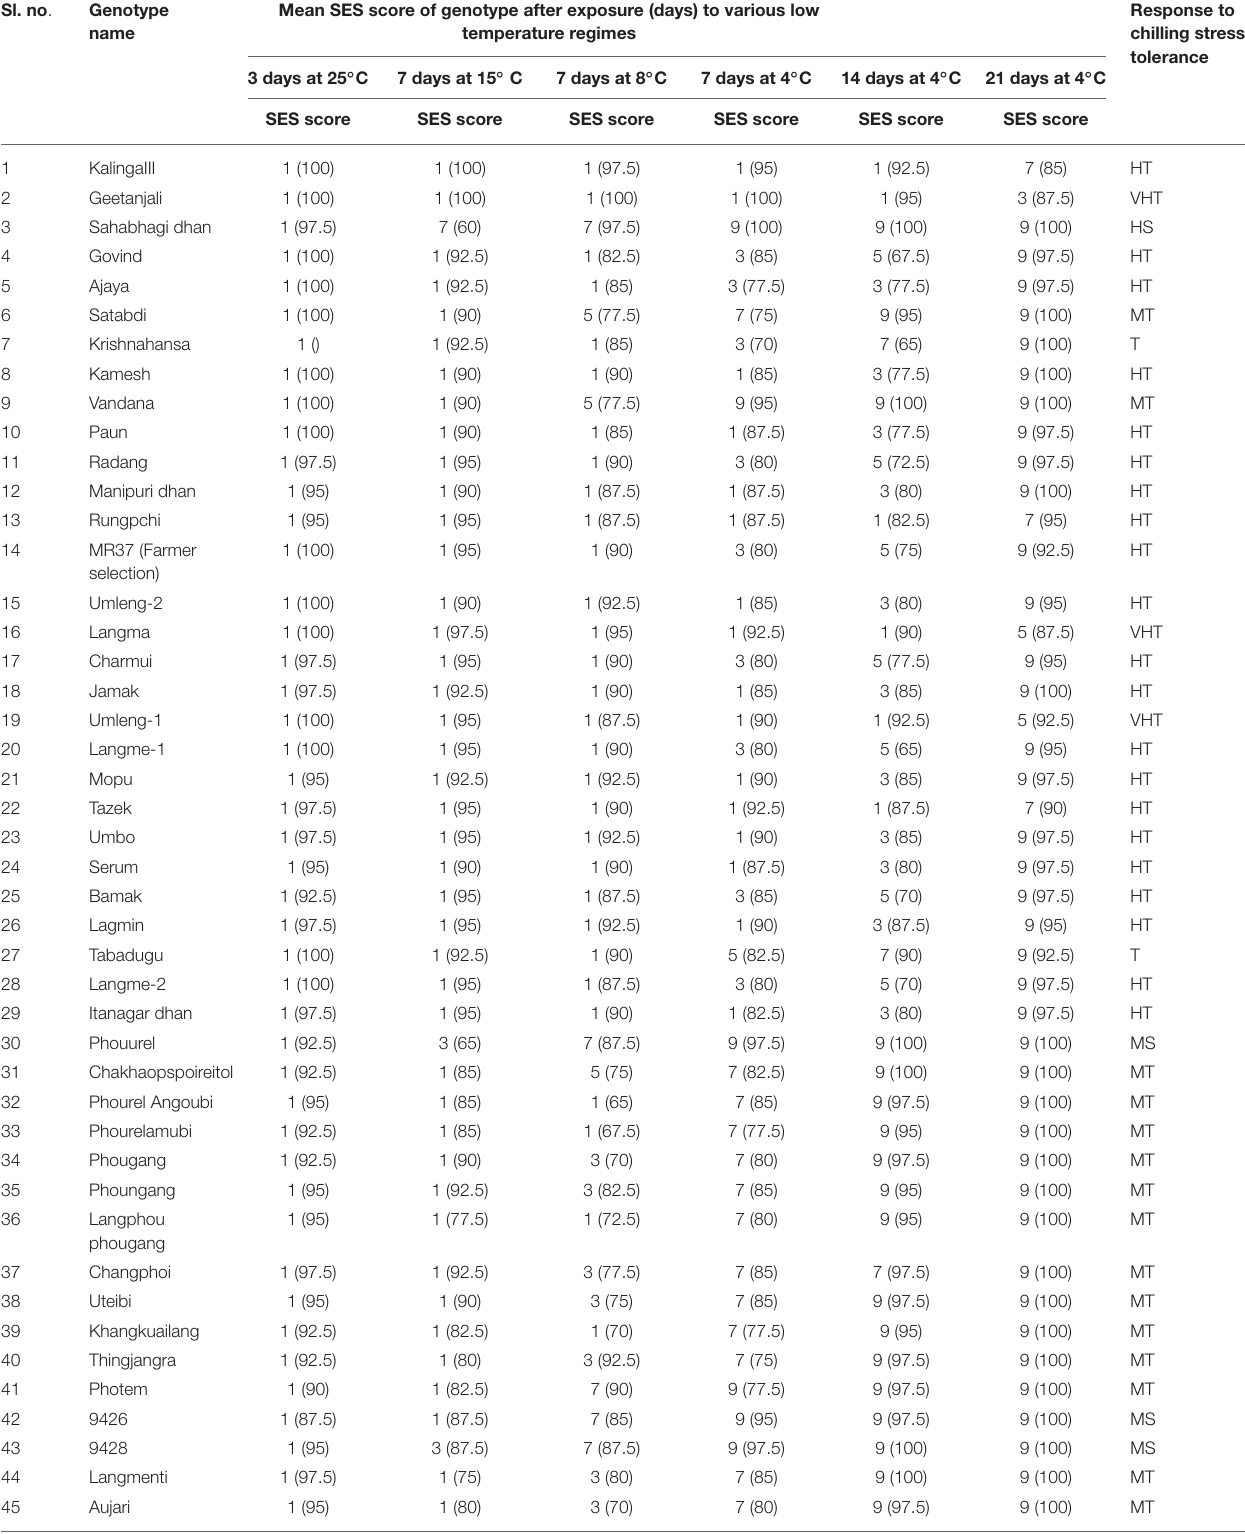
TABLE 1 | Average score for seedling stage cold tolerance of 66 rice genotypes under cold growth chamber at different temperature regimes. Sl. no